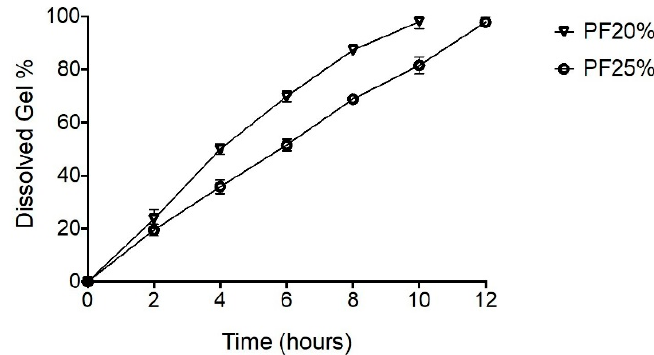
Figure 5. Degradation and erosion behavior of different concentrations of NPH-PF127 using the dialysis method at 37 °C. Data are expressed as means ± S.D. ( n = 3).